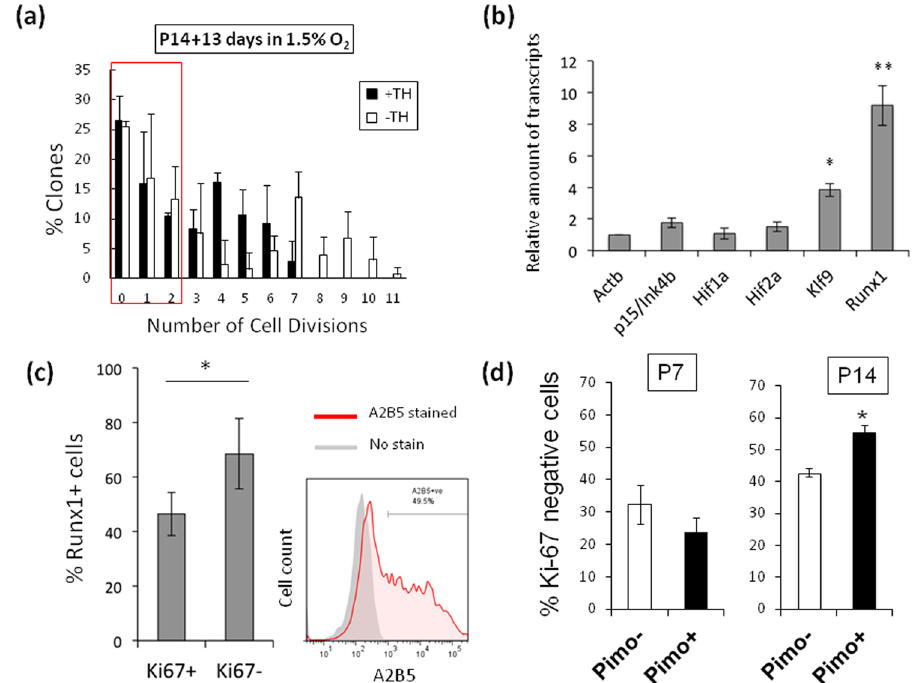
Figure 7. Relevance of adult-like OPCs in culture and adult OPCs in P14 rat optic nerves. ( a ) Clonal analysis of P14 A2B5 + /GC − OPCs cultured at clonal-density in PDGF in 1.5% O 2 with TH ( black bars ) or without TH ( white bars ). After 13 days, the number of cells in each clone was counted and the number of cell divisions was estimated (n = 3). Around 50% of clones contained the cells of which divided less than two times are shown in red square. ( b ) P7 OPCs and P14 OPCs were purified from rat optic nerve and their total RNA were prepared immediately. qRT-PCR analysis was carried out. The resulting values were normalized to the endogenous control gene, Actb . Results of P14 OPCs are presented as the relative expression to those of P7 OPCS using the ∆∆ Ct methods. * P < 0.001, ** P < 0.001 (ANOVA with Fisher’s LSD test, n = 3). ( c ) GC-negative optic nerve cells prepared from P14 rat were sorted with A2B5 monoclonal antibody ( right panel ). These GC − /A2B5 + were stained for Runx1 and Ki-67 and examined in immunochemistry. The percentages of Runx1 expressing cells in Ki-67 + or Ki-67 − cells are shown ( left graph ). * P < 0.01 (unpaired Student’s t -test, n = 10). ( d ) Pimonidazole was injected intraperitoneally into P7 rats or P14 rats. 2 hours later, OPCs were purified from the rat optic nerves. These cells were stained for pimonidazole and Ki-67. The percentages of Ki-67 − OPCs that were Pimo − ( white bars ) or Pimo + ( black bars ) at P7 and P14 are shown. * P < 0.001 (unpaired Student’s t -test, n =